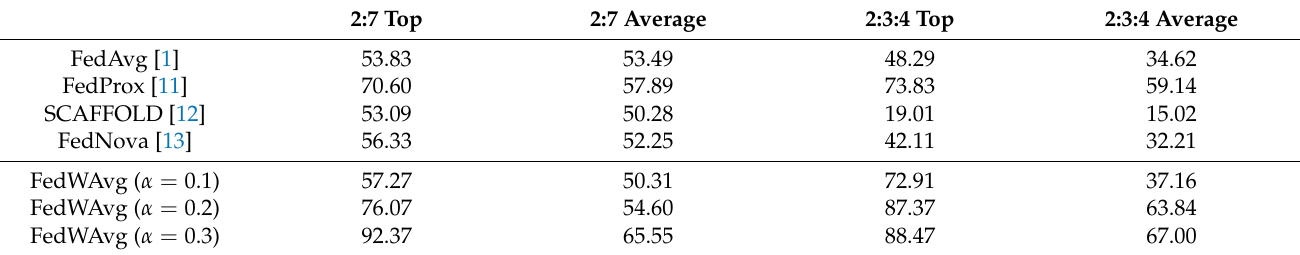
Table 4. Test accuracy (%) for SVHN.